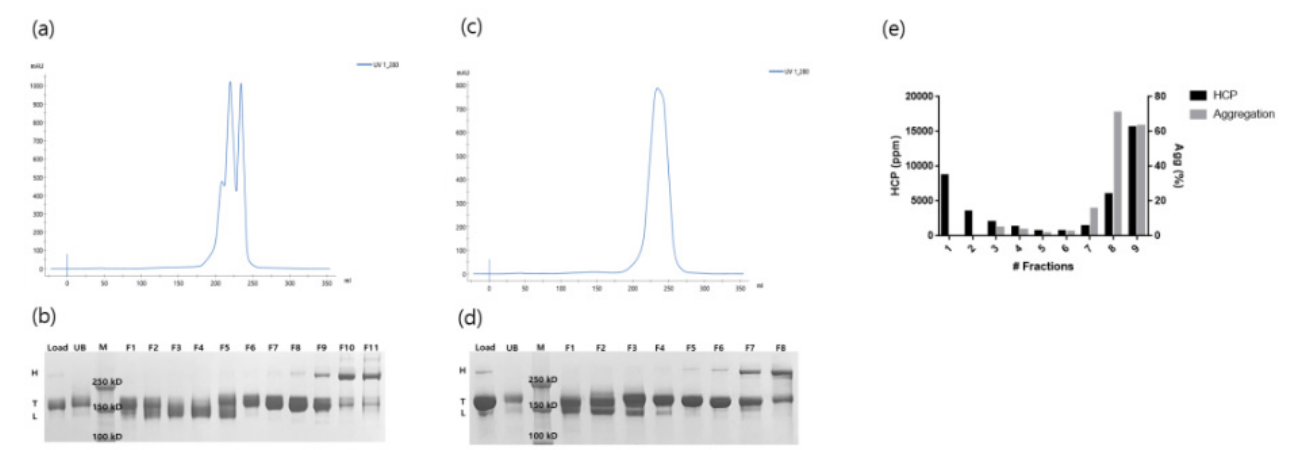
Figure 3. Chromatogram and SDS-PAGE results using two strong cation exchange resins. Con- ductivity is set to 35 mS/cm for fraction #1 (F1) of each resin. Band H: HMW proteins, band T: target protein, band L: LMW proteins. ( a , b ) Linear gradient results using Capto TM SP ImpRes resin. ( c , d ) Linear gradient results using Fractogel ® EMD SO 3 − (M) resin. ( e ) Gradient elution fractionation. HMW (aggregation) and HCP levels for each fraction are shown relative to the Fc-fusion protein elution peak.